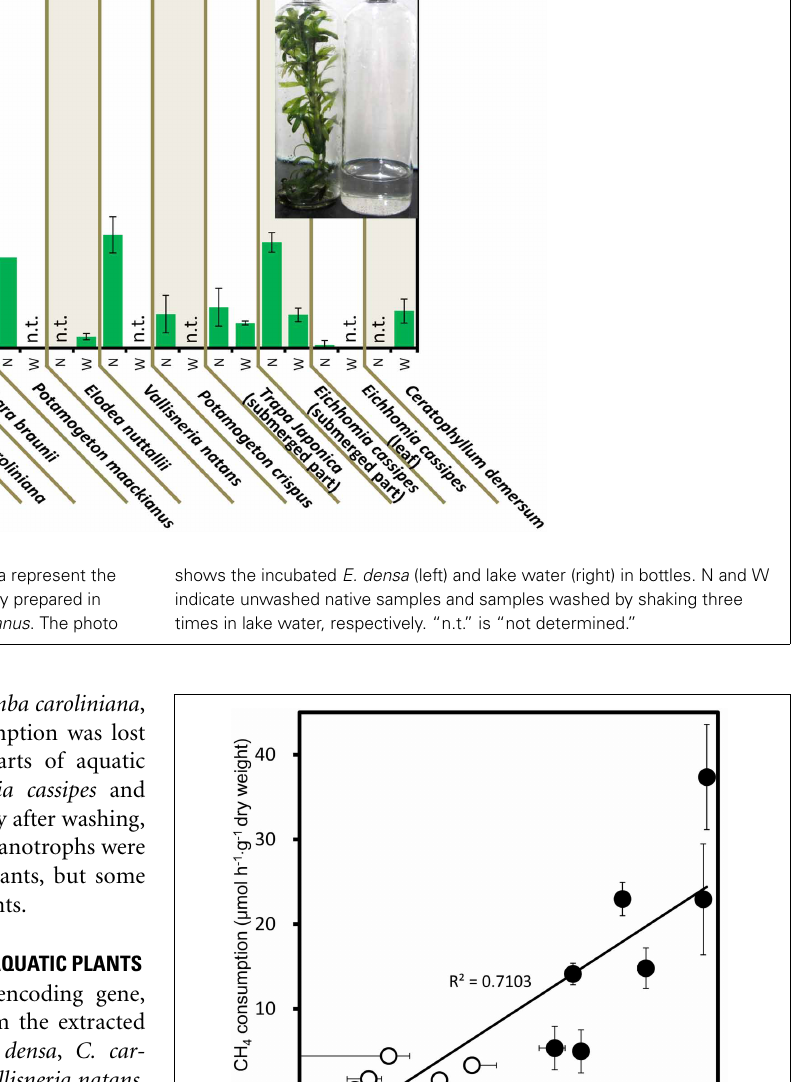
FIGURE 3 | Correlation of qPCR estimated pmoA copy numbers and CH 4 consumption activities in the aquatic plants. Filled circles and open circles represent the data from the native and slightly washed samples, respectively. Data represent the mean ± SD from three different samples independently prepared in